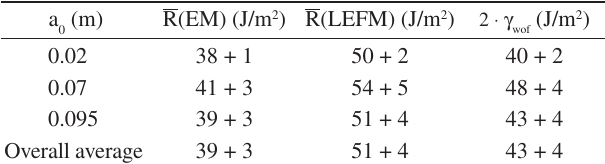
Figure 12. P-d curves for a)